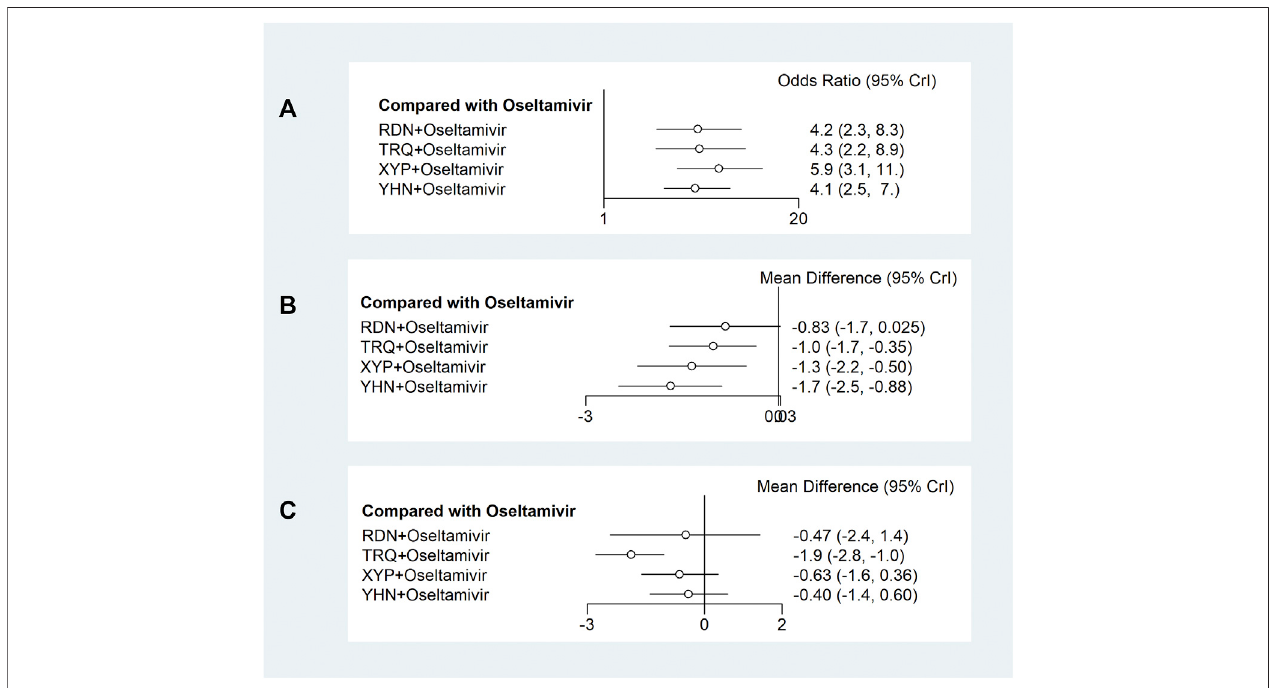
FIGURE 3 | Forest plots of primary outcomes. XYP, Xiyanping; RDN, Reduning; TRQ, Tanreqing; YHN, Yanhuning. (A) Response rate; (B) disappearance time of fever; (C) disappearance time of cough. 95% CrI: 95% credible interval.